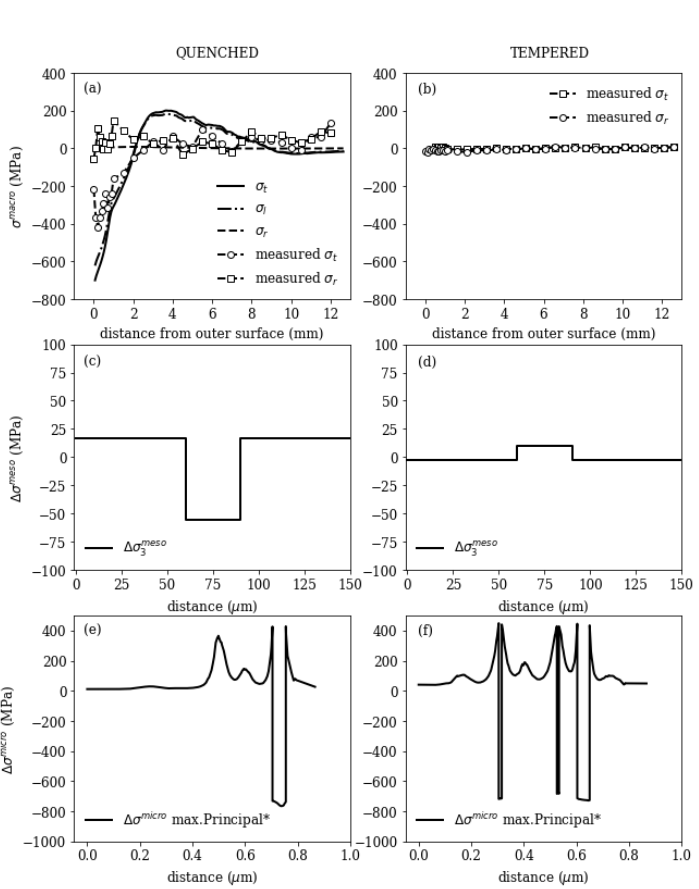
Figure 11. Macroscopic, mesoscopic and microscopic residual stresses for quenched (left) and tempered state